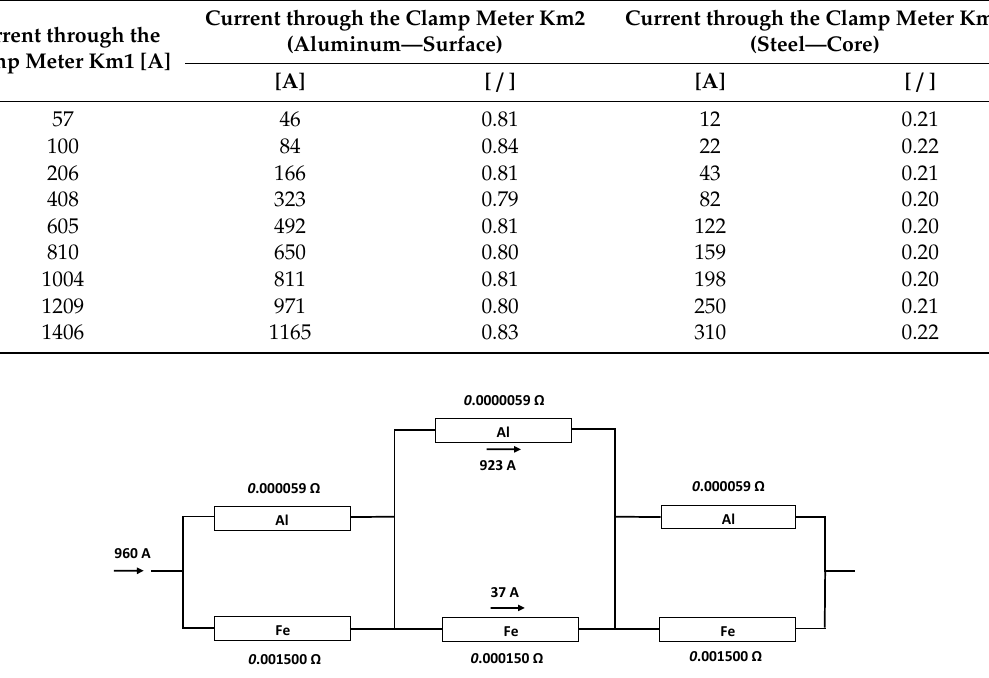
Figure 8. ( a ) Measurement scheme with interrupted aluminum coat. ( b ) Picture of measurement with interrupted aluminum coat. Table 2. Results of measurement with interrupted aluminum coat.